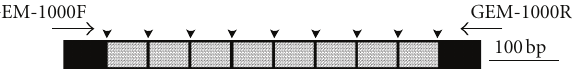
Figure 1: Schematic structure of pGEM-800 plasmid. The plasmid contains an insert of 800 bp which is a multimer of 100 bp repeats separated by the same unique Sma I restriction enzyme site (indicated by arrows). The GEM-1000F and GEM-1000R primers were designed to flank 800bp insert plus 200 bp in length based on the pGEM